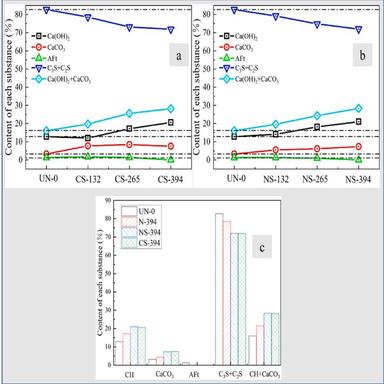
Variation curve of material content under subsequent hydration action: (a) CS; (b) NS; (c) Crystal content after 394d of subsequent hydration in different environments.